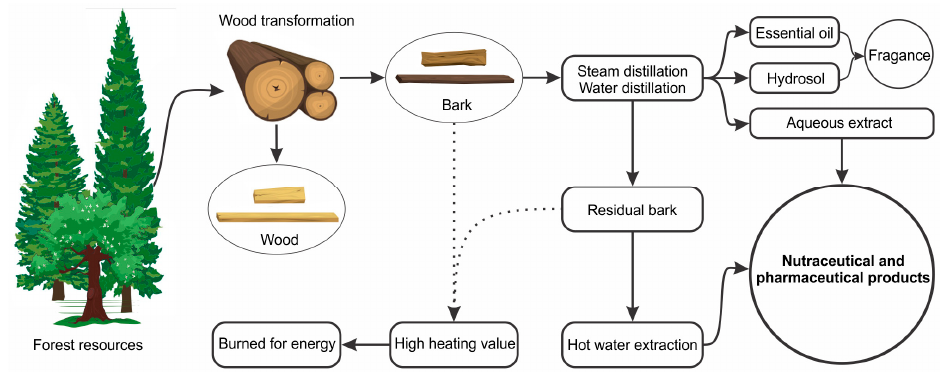
Figure 5. Proposed integrative process to obtain valuable extracts from Picea mariana bark in the context of existing forestry practices.